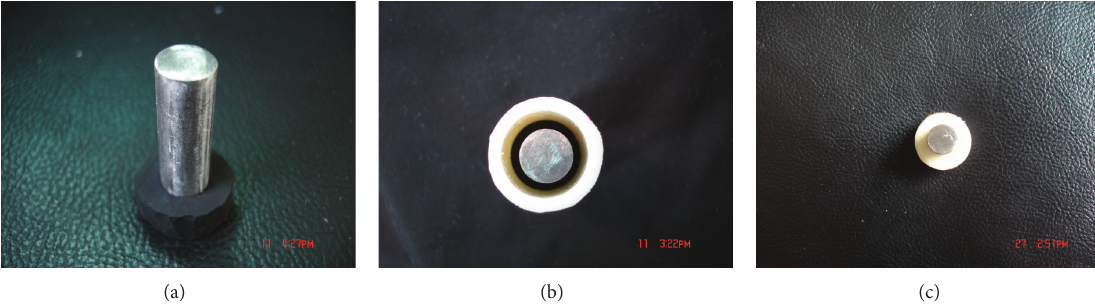
Figure 1: (a) Stainless steel cylinders locating in the center of the axial positioning ring; (b) The metal rod positioning system: stainless steel cylinders locating in the center of hollow polypropylene tubes; (c) Metal-bone cement